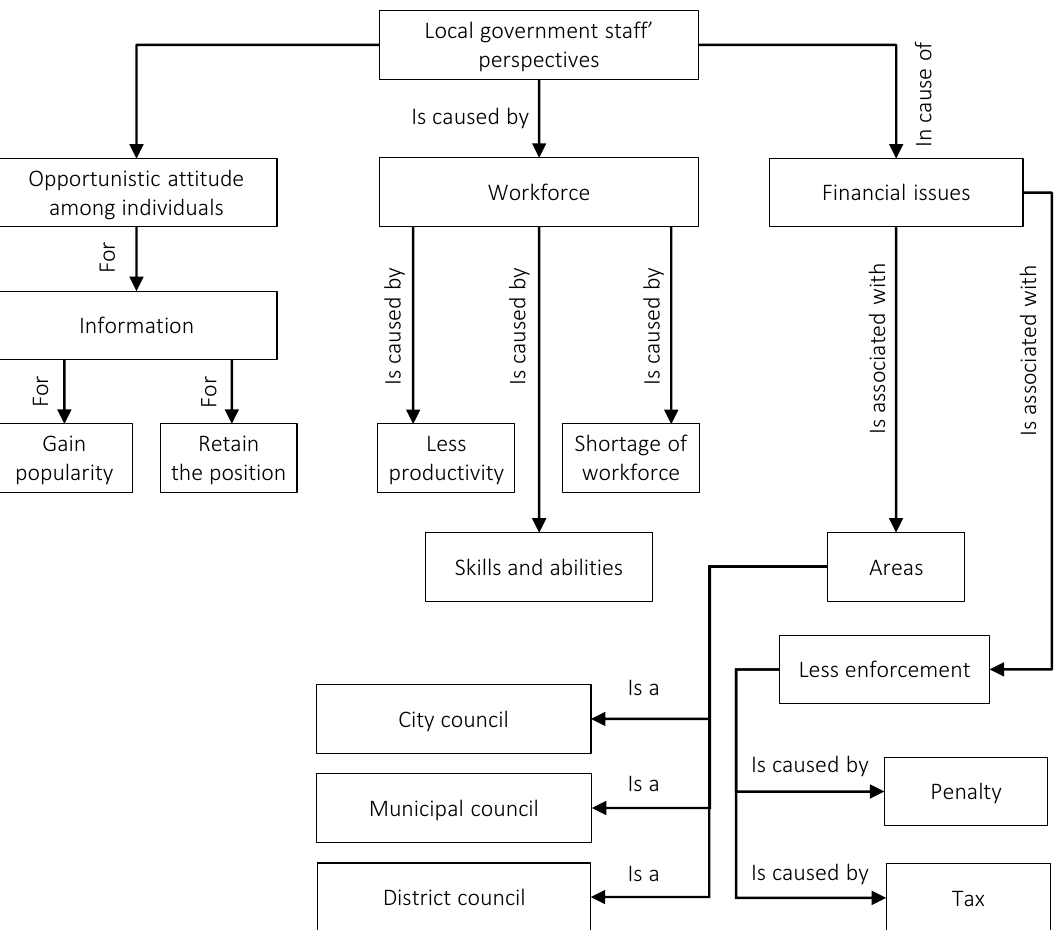
Figure 2. Integrity and enforcement frameworks from LG regulator’s